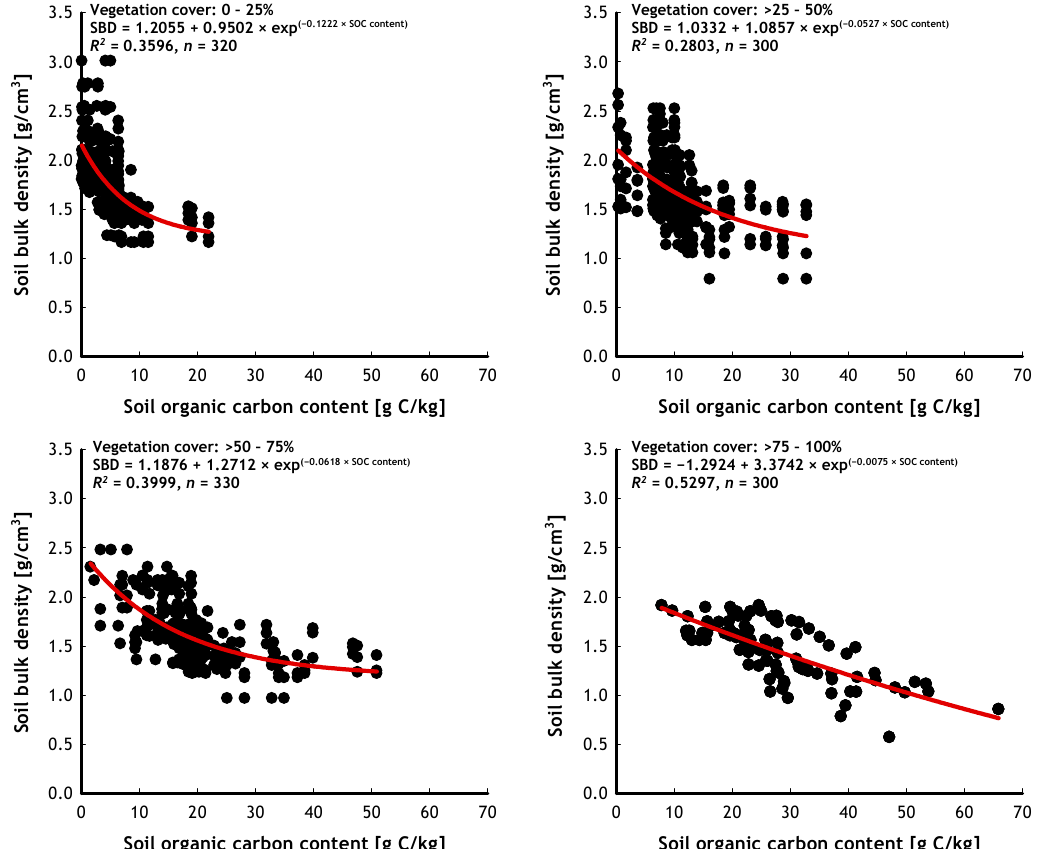
Vegetation cover: 0 – 25%